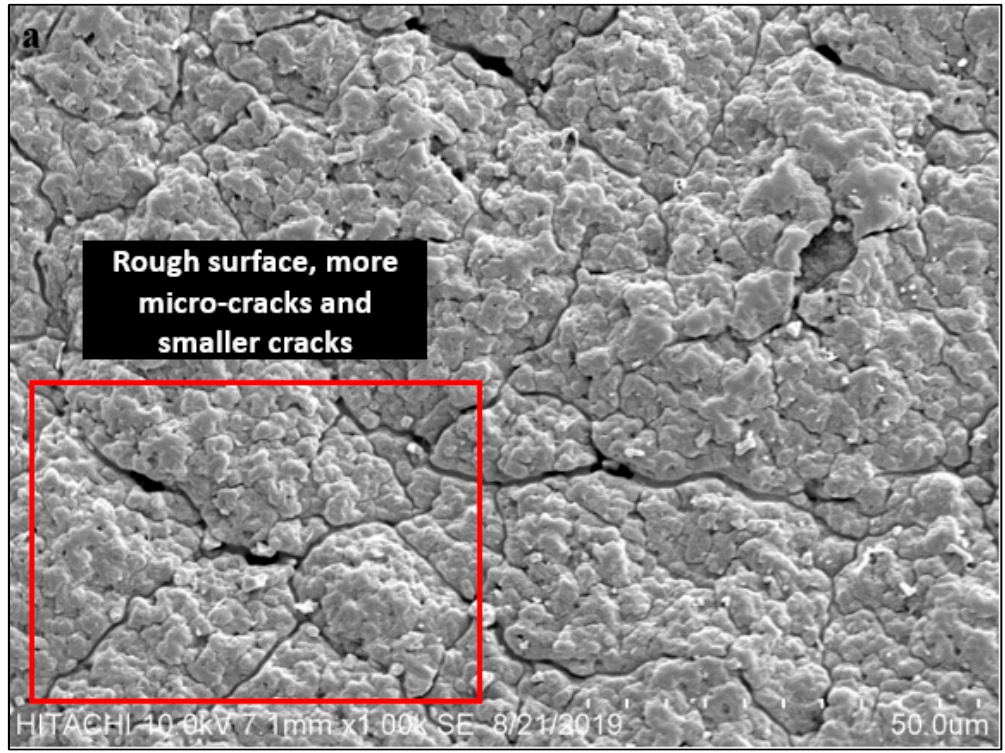
Figure 7. SEM of 7% NaOH treated rubber surface morphology. Appl. Sci. 2020 , 10 , x FOR PEER REVIEW